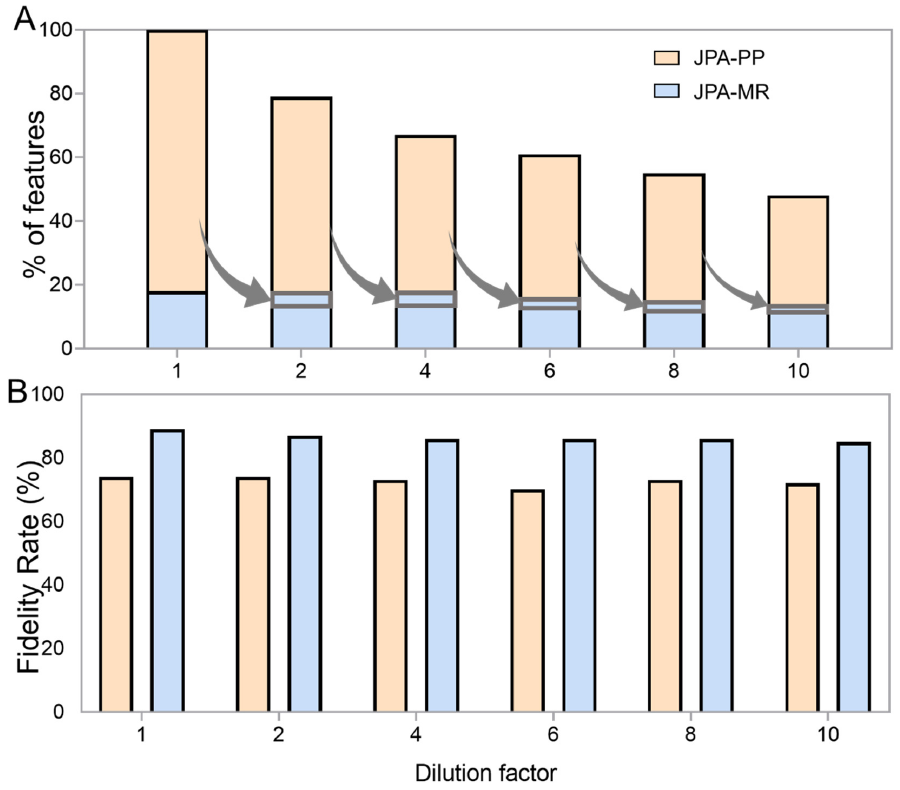
Figure 3. The influence of dilution on the ( A ) number and ( B ) fidelity rate of features extracted by JPA-peak picking (JPA-PP) and JPA-MS 2 recognition (JPA-MR) in urine.